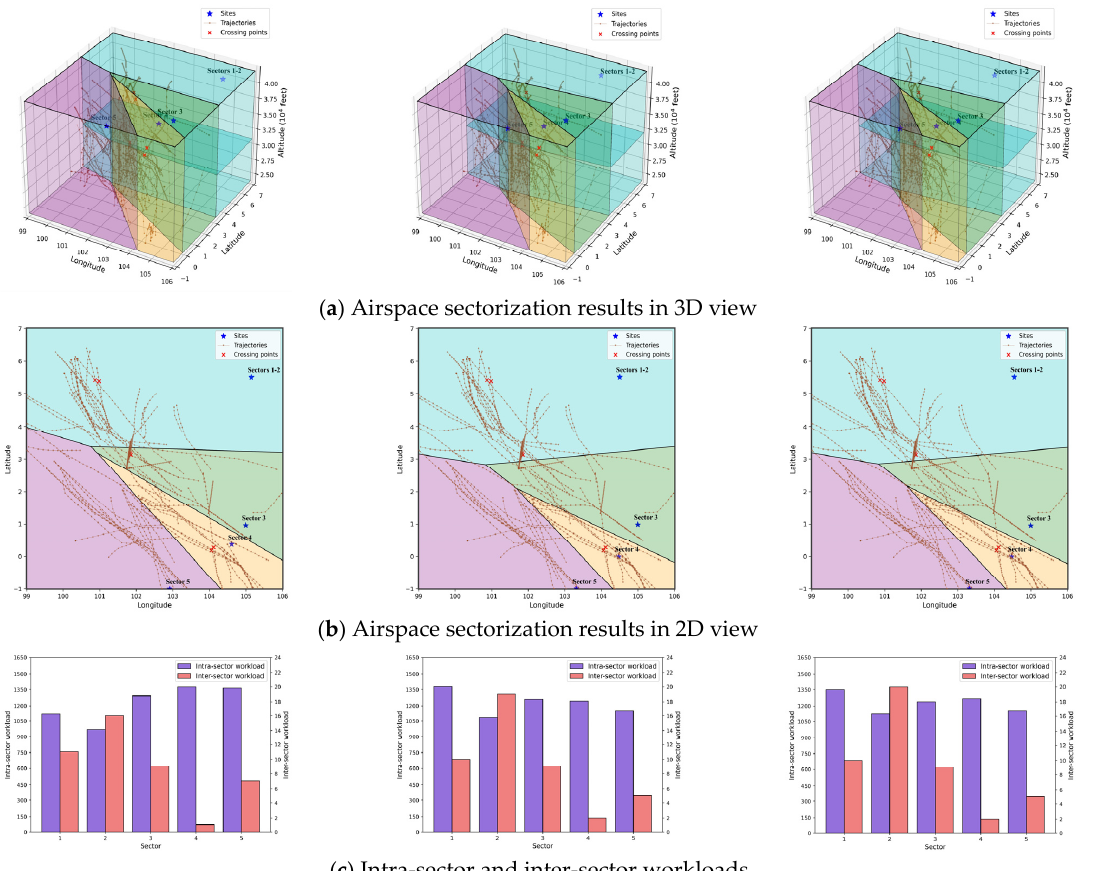
Figure 8. Airspace sectorization results for area one (i.e., solutions of [0.128, 44], [0.082, 45], and [0.064, 46] in Run 1). ( a ) Results in 3D view; ( b ) results in 2D view; ( c ) intra-sector and inter-sector workloads for each solution.